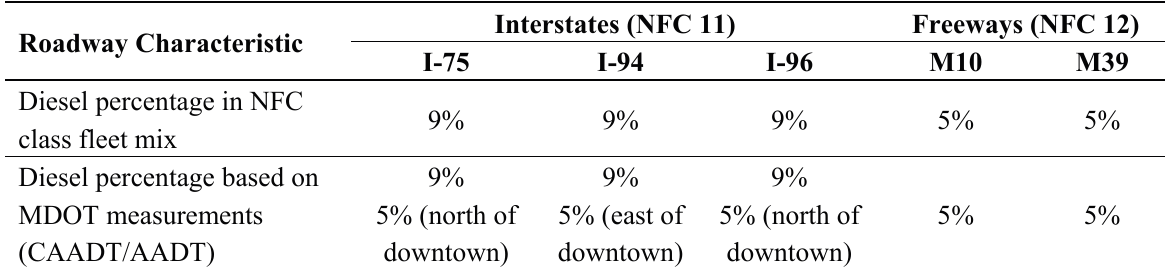
Table 7. Comparison of diesel percentages based on NFC class and CAADT/AADT measurements on selected interstates and